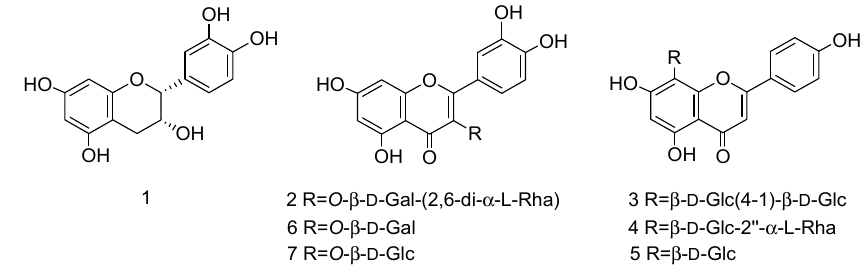
Figure 1. Structures of the compounds from C. pinnatifida.